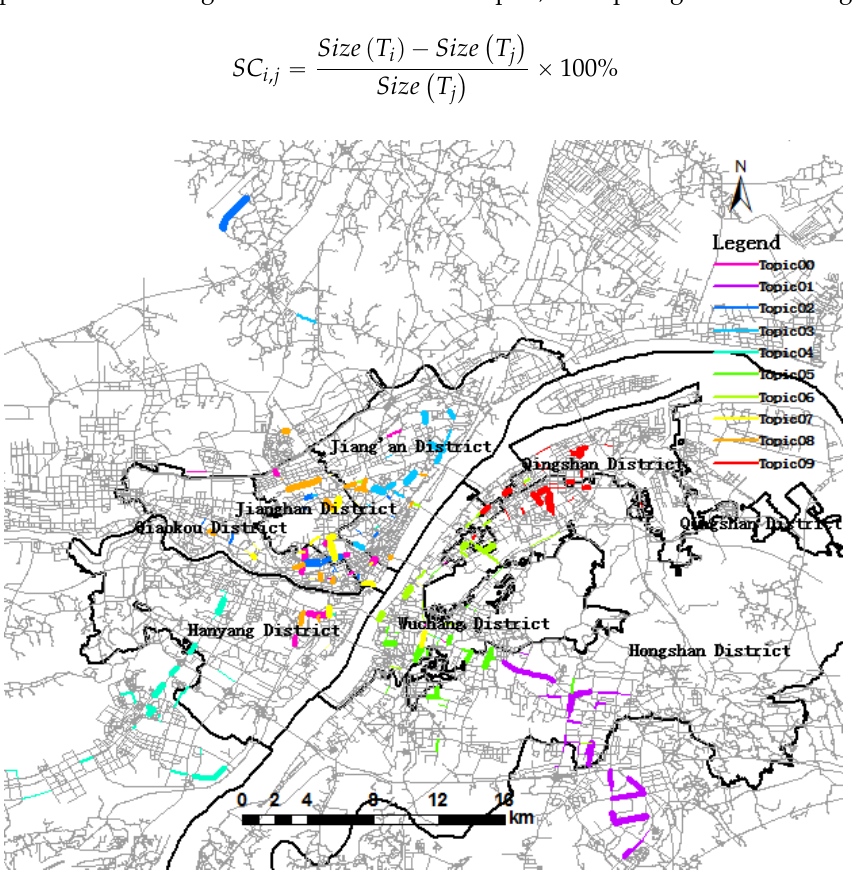
Figure 11. Ten topics during the evening rush hour period.